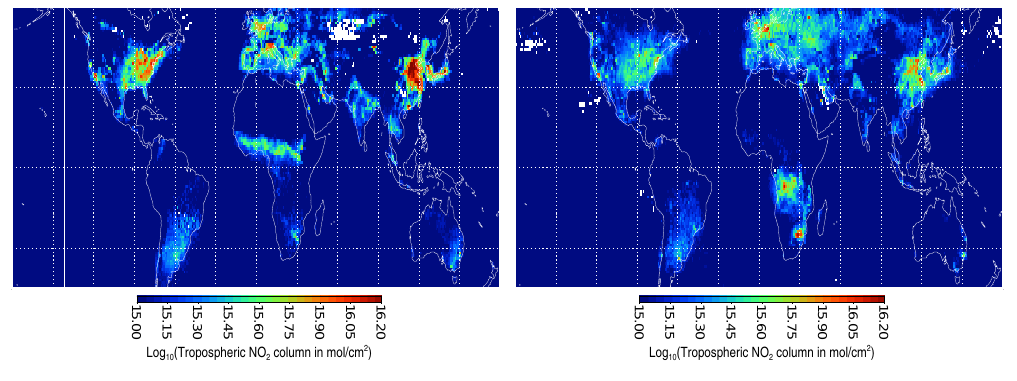
Fig. 6. Monthly-mean tropospheric NO 2 column amounts for January (left) and July (right) 2005 from OMI. White areas correspond to pixels not meeting the cloud fraction criterion.